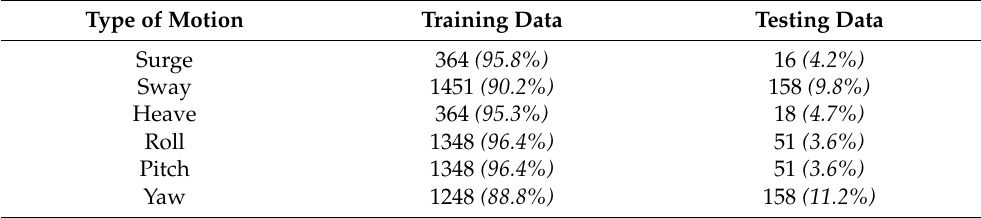
Table 1. Size of data samples used for training and testing the prediction model. Number of hourly subsets for each type of motion in the available dataset. Percentage (%) of data, with respect to the whole dataset, used for training and testing.